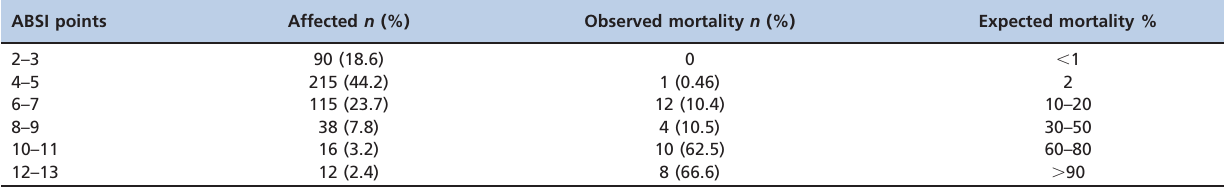
Table 2 - Expected and observed mortality according to the ABSI scale ( n = 486). ABSI